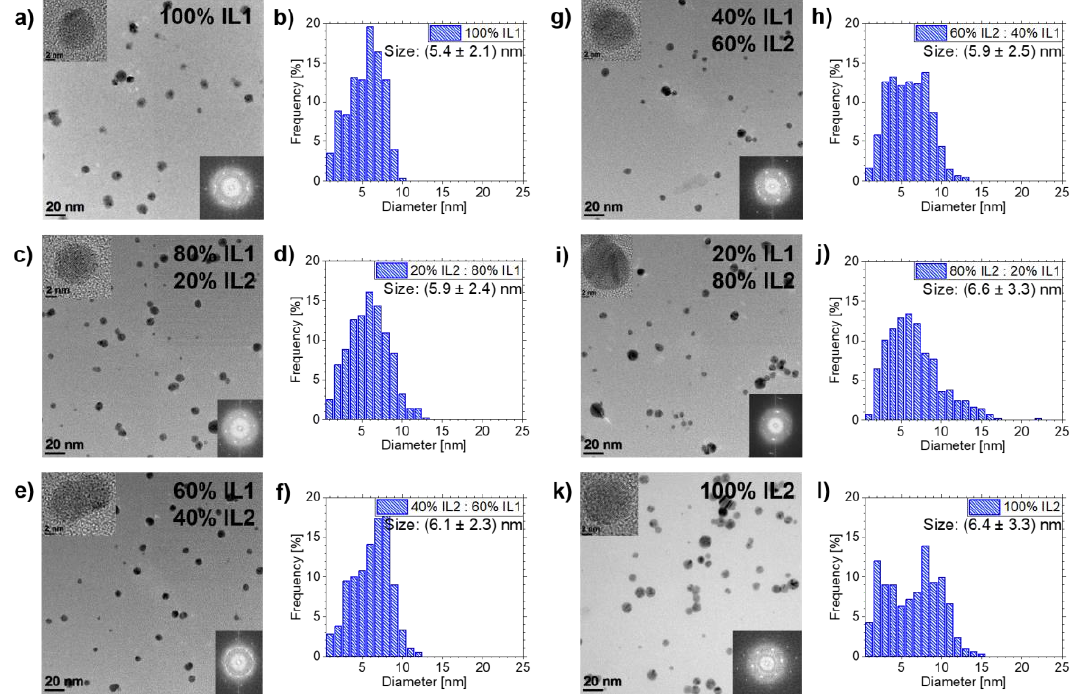
Figure 3. Overview of TEM results of Ag NPs sputtered in IL1 / IL2 -mixtures and pure ILs as references. TEM images and the corresponding NP size distribution are depicted in ( a , b ) for IL1 . Overview images and NP size distributions for the IL1 / IL2 -mixtures are shown in ( c , d ) for 80 vol.% IL1 / 20 vol.% IL2 , in ( e , f ) for 60 vol.% IL1 / 40 vol.% IL2 , in ( g , h ) for 40 vol.% IL1 / 60 vol.% IL2 and in ( i , j ) for 20 vol.% IL1 / 80 vol.% IL2 . Results of pure IL2 are illustrated in ( k , l ). HRTEM images of NPs from the investigated IL (mixtures) and corresponding FFT images are depicted as insets in the overview images, confirming the NP crystallinity due to visible lattice fringes and the corresponding spots in the FFTs.